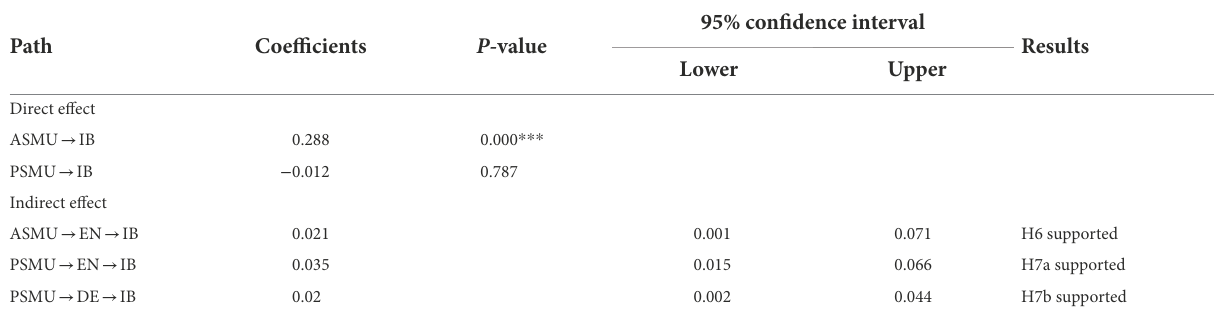
TABLE 5 Mediating effect test results.